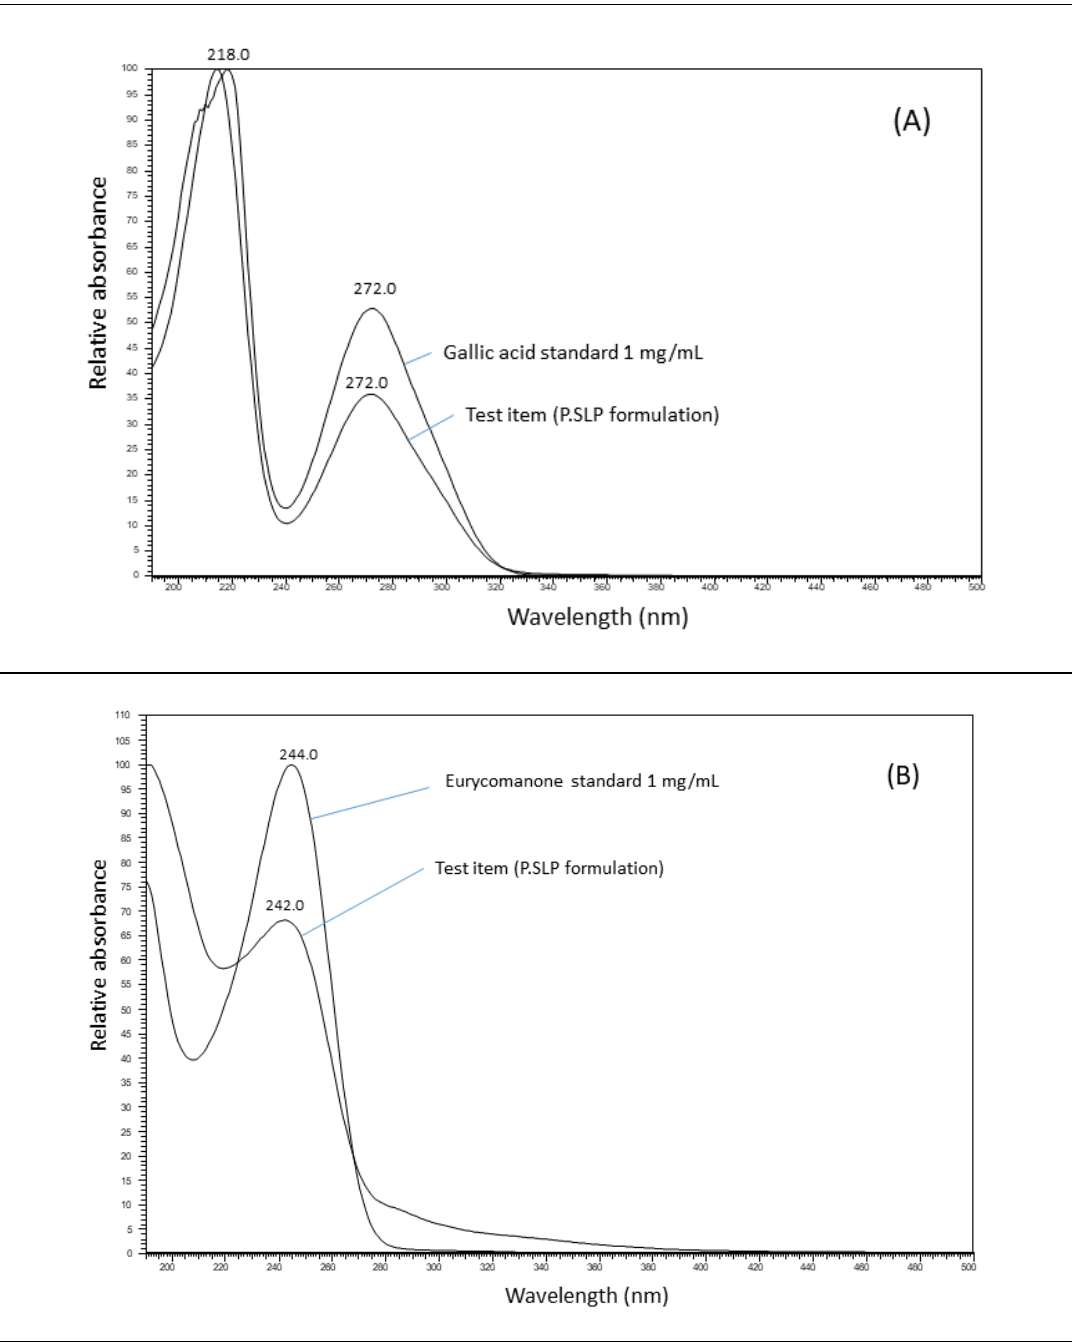
Figure 3. UV spectrum of ( A ) gallic acid standard (1 mg/mL) and ( B ) eurycomanone standard (1 mg/mL) overlaid with methanol solution of the P.SLP formulation.